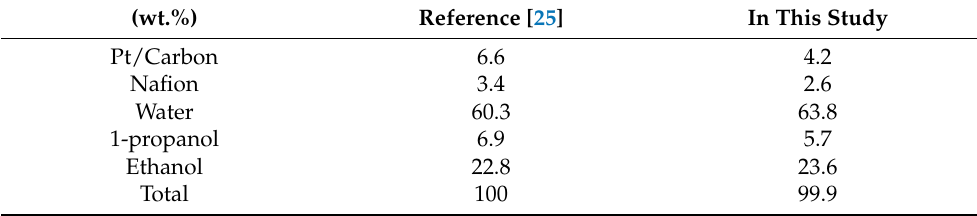
Table 3. Comparison of catalyst ink